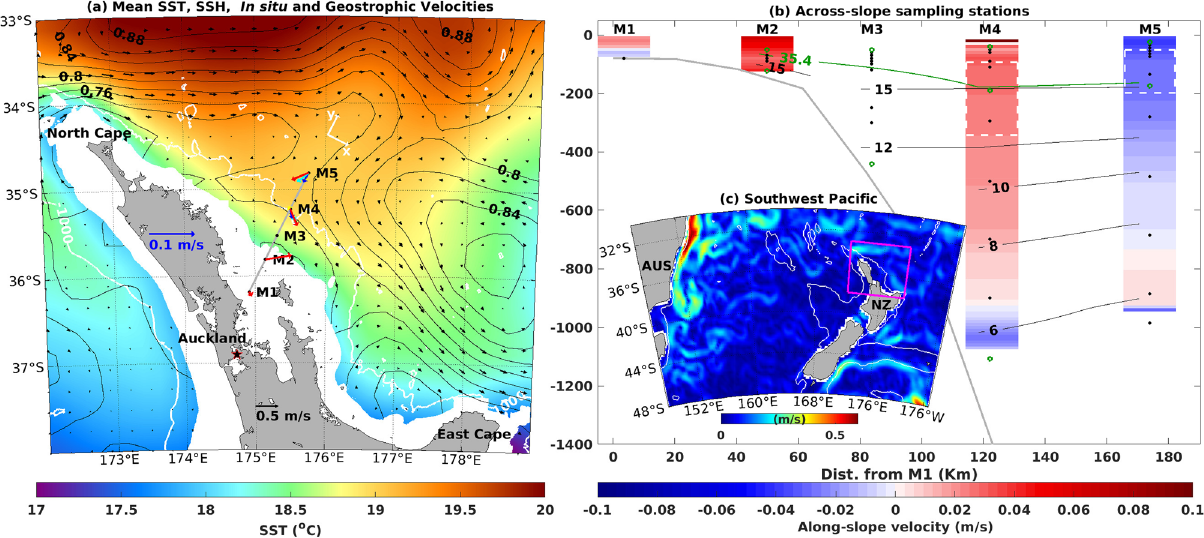
Figure 1. ( a ) Study area showing the average SSH (black contours), geostrophic velocities (black arrows) from AVISO, and sea surface temperature (SST) (shading) from AVHRR. Regions shallower than 200 m are masked (white). The coloured arrows represent, where possible, the vertically averaged (bin = 280 m) in situ velocities centered at 140 m (red), 420 m (cyan), 700 m (blue), and 980 m (yellow). The white arrows represent the orientation axes used. The stations M1 to M5 are indicated along the grey line. ( b ) Temporal averages of depth-resolved along-slope (U) velocities (shading), temperature (black contours), and salinity (green contour). The white-dashed rectangles show regions of interpolated velocities between the median depths of the upper ADCP and top bin of the lower ADCP. The vertical positions of thermistors and CTDs are indicated as black dots and green circles, respectively. A deeper CTD is located at M5 in 1864.6 m depth but it is not shown here. ( c ) Location of the study area (magenta contour) relative to other currents in the Southwestern Pacific Ocean. The colors represent the 1-year average of geostrophic speed. The 1000-m isobath is shown as a white contour in ( a ) and ( c ). The maps were generated with m_map (http:// www. eos. ubc. ca/